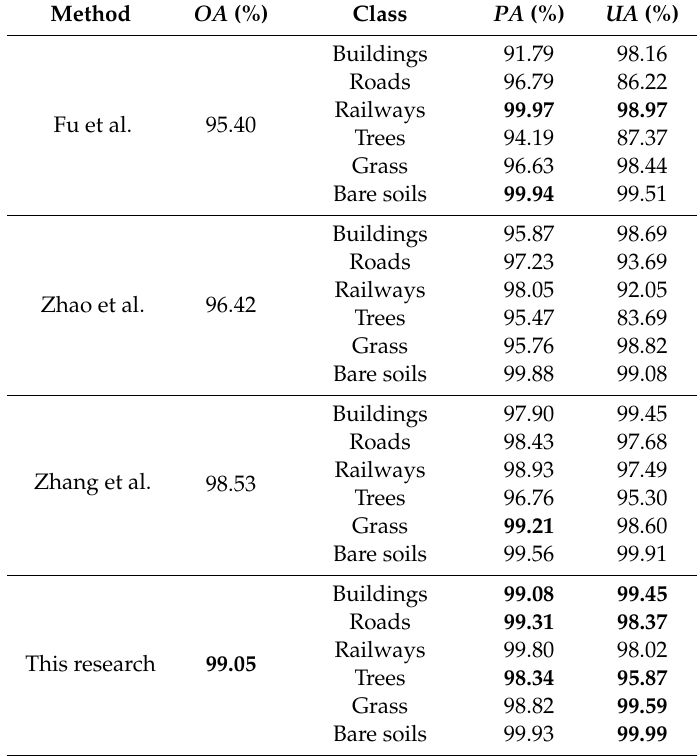
Table 5. Comparison of classification accuracies on Zurich dataset (bold numbers represent the highest OA , the highest PA of each class, and the highest UA of each